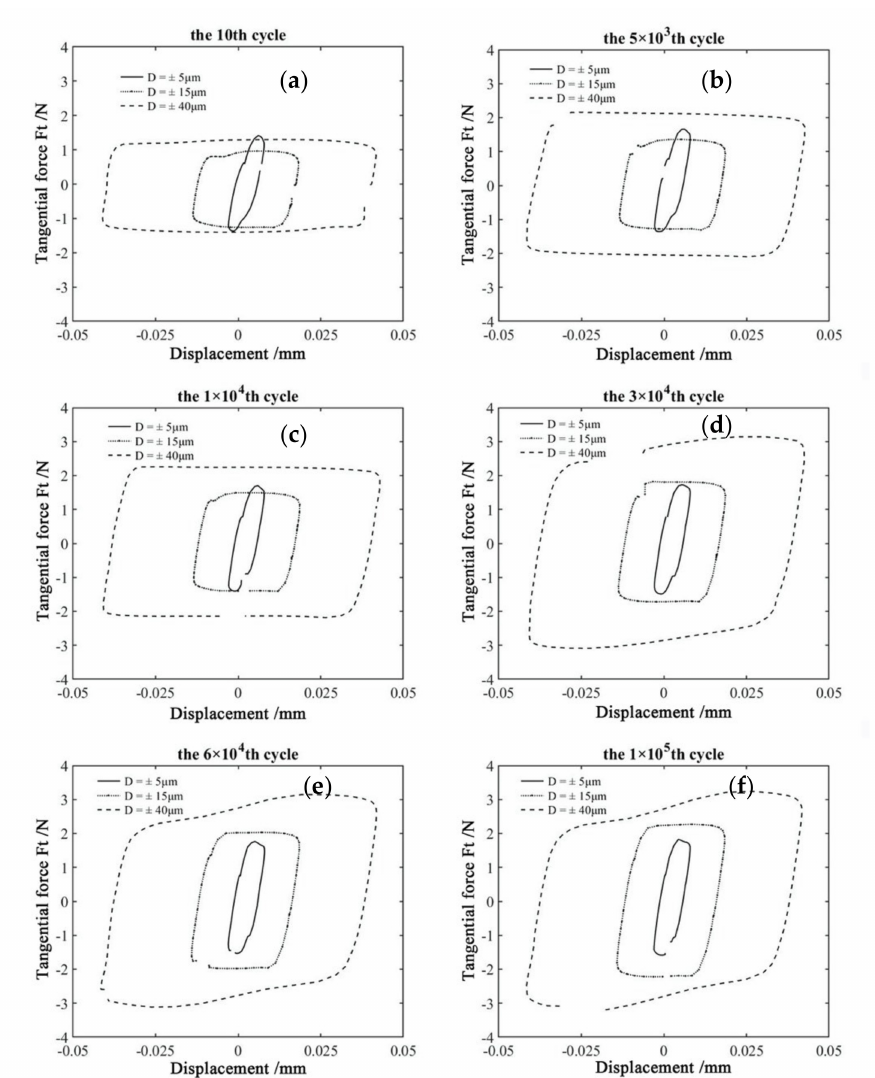
Figure 5. The comparison of F t − d curves of PVDF thin films in different number of cycles with F n = 15 N, ƒ = 15 Hz, and V c = 0 V ( a ) 10th cycle, ( b ) 5 × 10 3 th, ( c ) 1 × 10 4 th, ( d ) 3 × 10 4 th, ( e ) 6 × 10 4 th, and ( f ) 1 × 10 5 th.